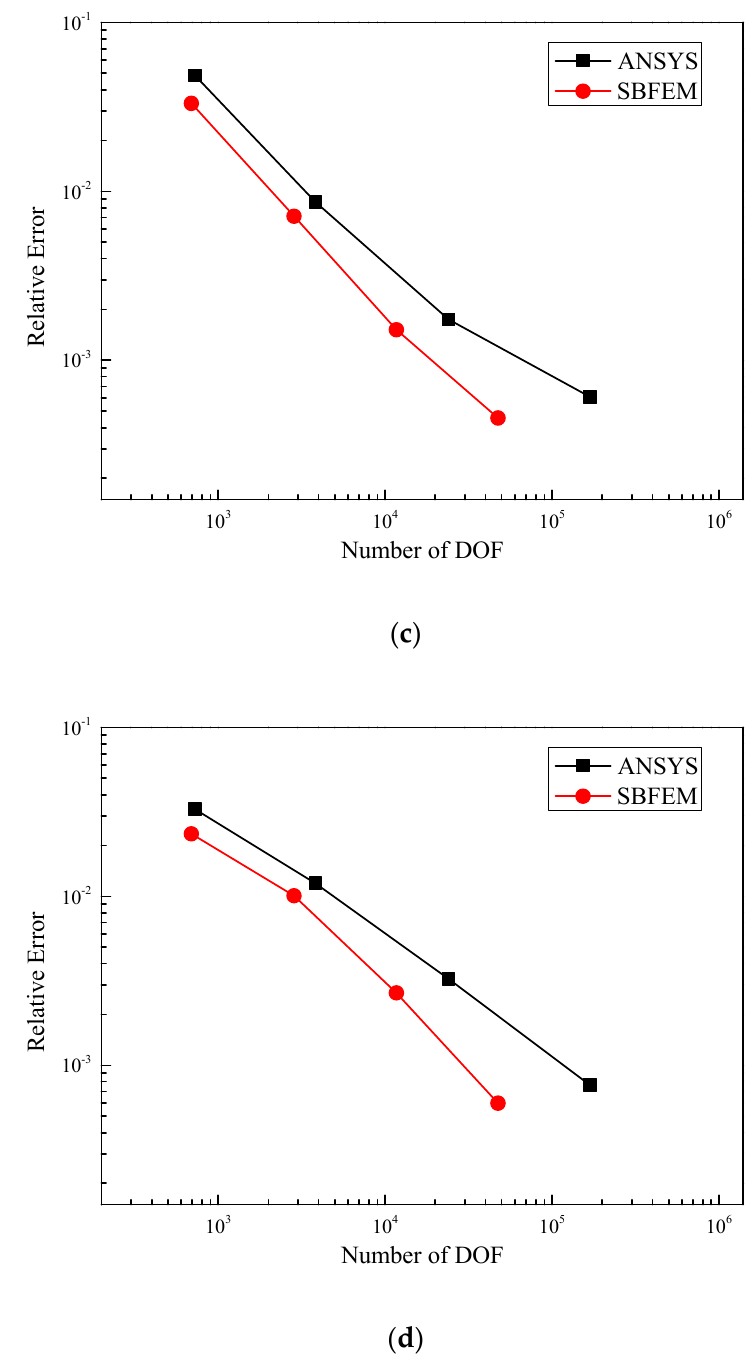
Figure 10. The relative error of displacements in Z direction vs. number of DOF. ( a ) The relative error of displacement in Z direction at endpoint A. ( b ) The relative error of displacement in Z direction at endpoint B. ( c ) The relative error of displacement in Z direction at endpoint C. ( d ) The relative error of displacement in Z direction at endpoint D.